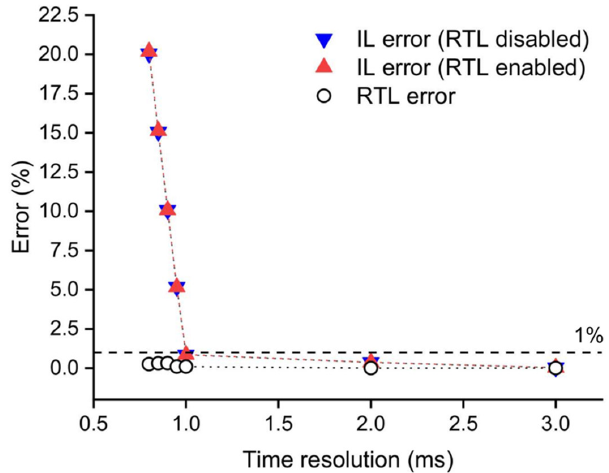
Figure 3. System performances at different time resolutions during 90 s of measurement. Imaging loop (IL) error rate calculated as the fraction of lost frames respect to total with real-time analysis loop (RTL) disabled (blue triangle) and enabled (red triangle). Real-time analysis loop error (black circle) calculated as the fraction of not analyzed frames respect to acquired